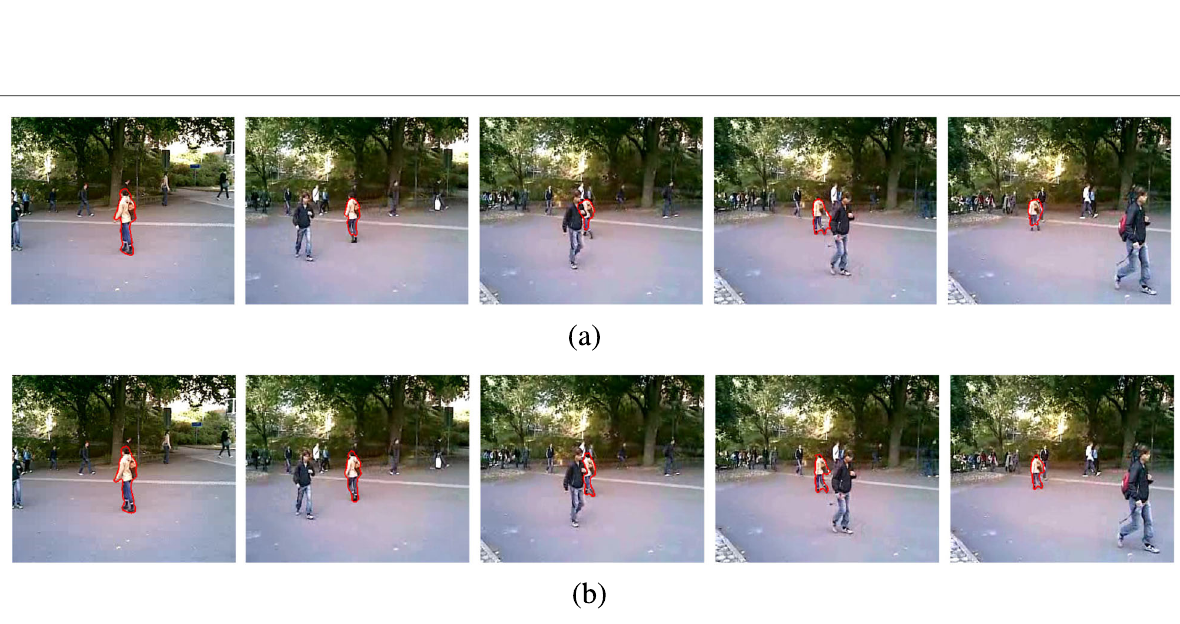
Fig. 6 Tracking results on pedestrian sequence for frames of 0, 17, 27, 33, and 47. a Conventional level set-based deformable object tracker [26]. b The proposed